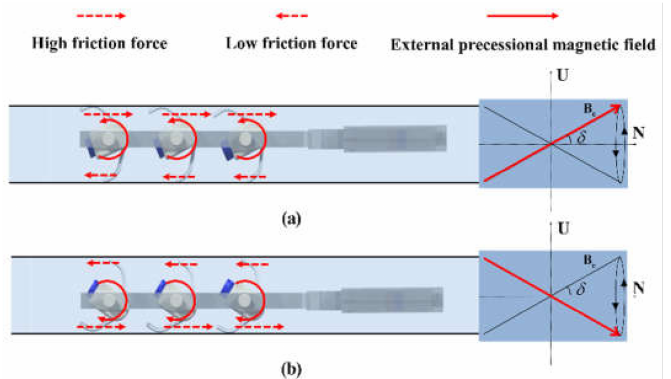
Figure 4. Principle of crawling motion with an external precessional magnetic field. ( a ) Counterclock- wise rotation of the crawling body. ( b ) Clockwise rotation of the crawling